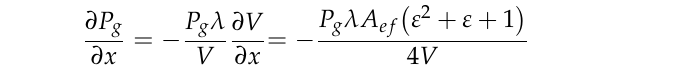
Figure 2. Parameters of the pneumatic spring.